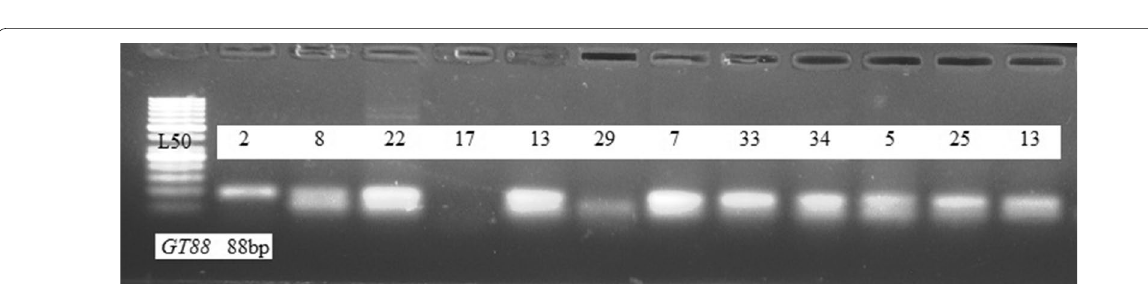
Fig. 2 Selected PCR amplification products of GT88 (88 bp) in some of the collected plant samples